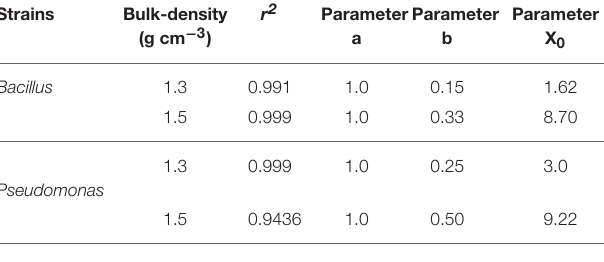
TABLE 5 | Parameters of sigmoidal curve fitting between fraction of replicates with successful spread and sampling days for Pseudomonas and